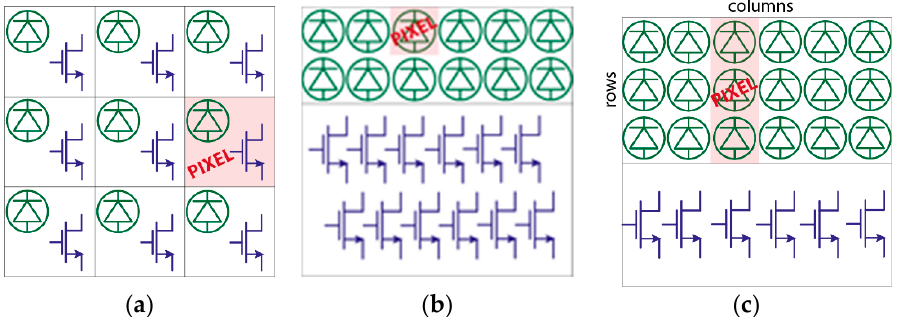
Figure 6. Example of ( a ) in-pixel and ( b ) out-of-pixel electronics for generic linear arrays, and ( c ) column pixels (associated to Raman lines) with out-of-pixel electronics for Raman linear arrays.